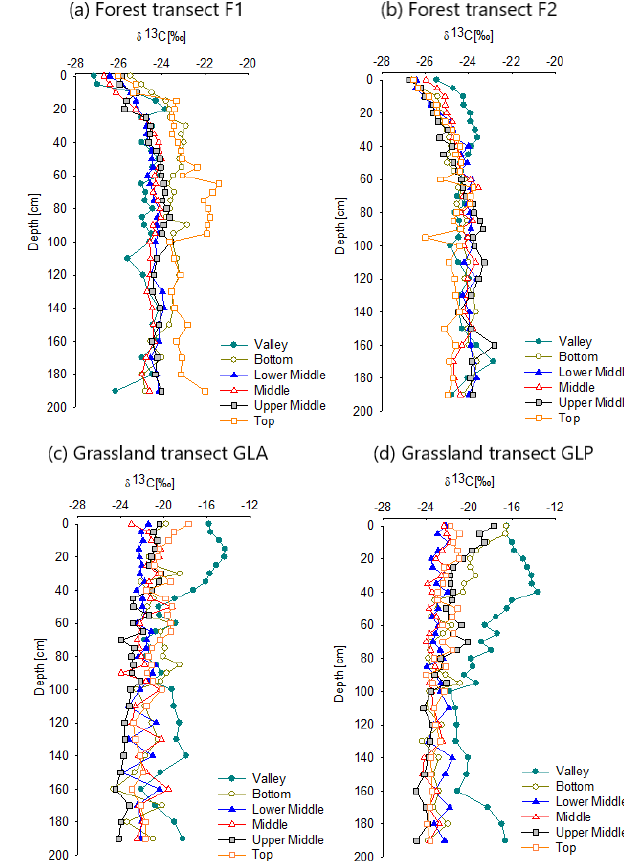
Figure 3. Depth profiles of δ 13 C for each sampling location (top, upper middle, middle, lower middle, bottom, valley) of the four transects including F1 (a) , F2 (b) , GLA (c) and GLP (d)